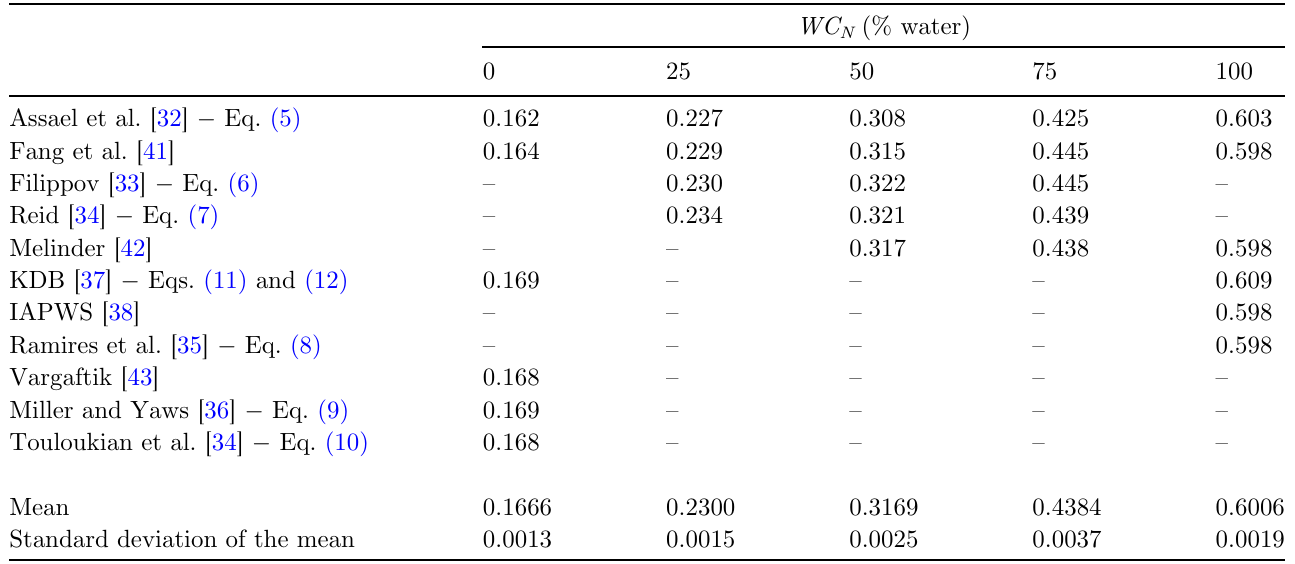
Table 3. Thermal conductivity values of the samples from literatures (in W/m ° C) at 20 °